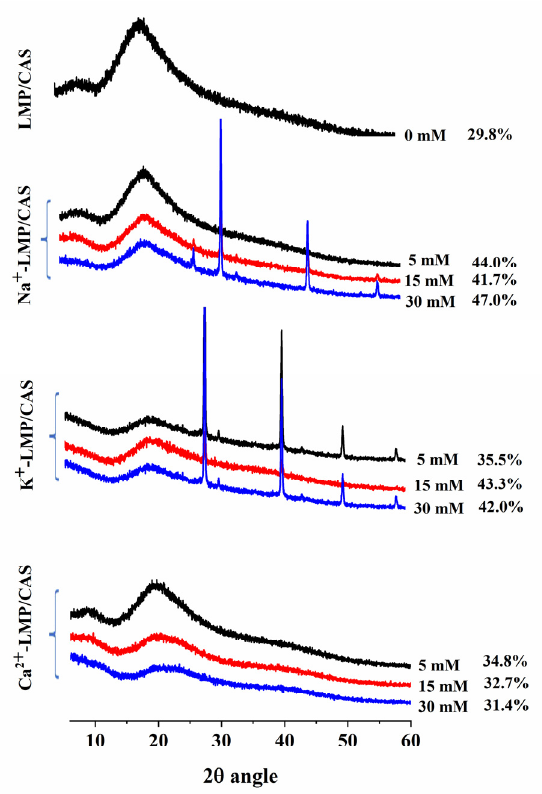
Figure 5. The X-ray diffractograms and the crystallinity of the low methoxyl pectin/sodium caseinate (LMP/CAS) complex.